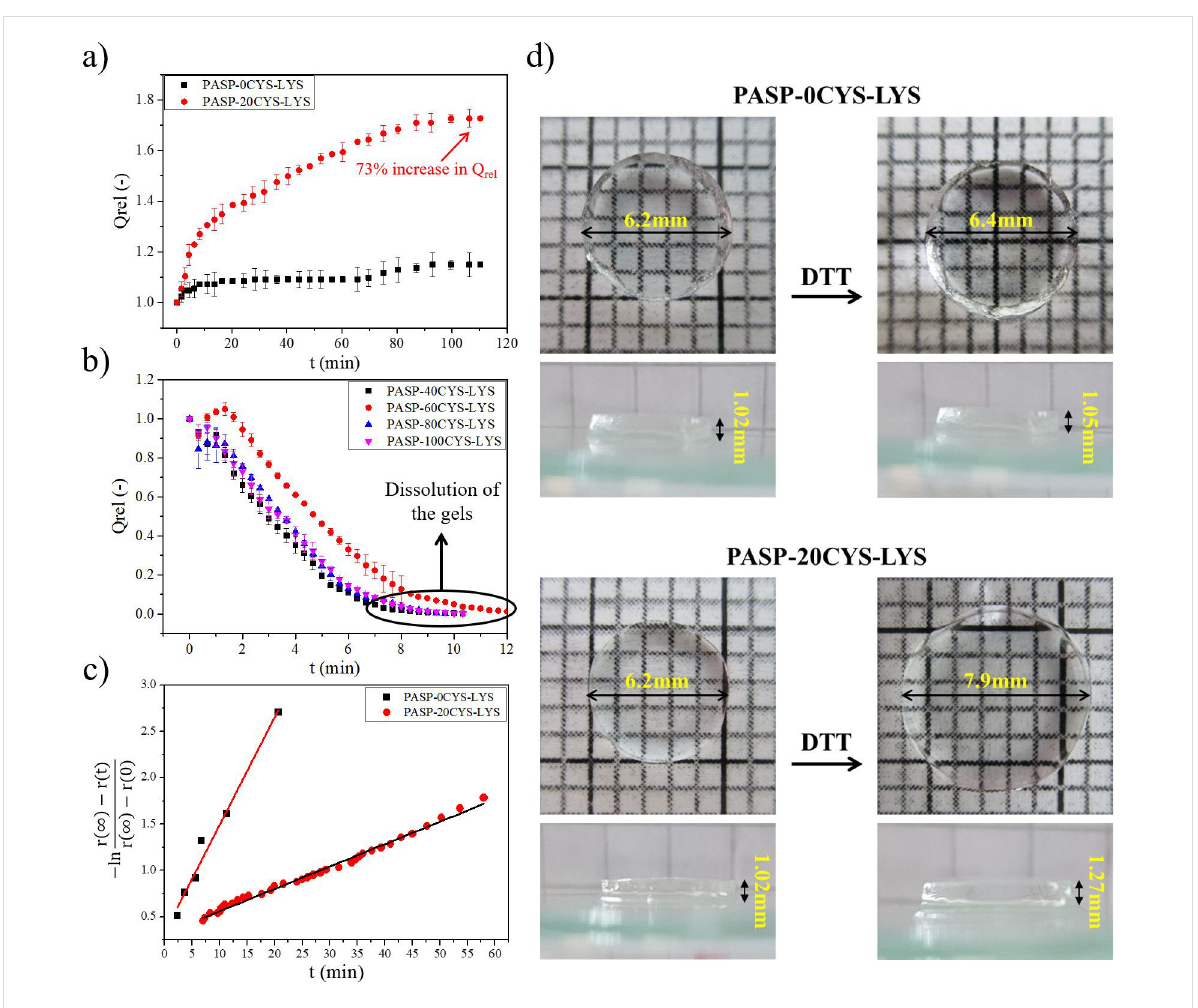
Figure 3: (a) Swelling and (b) dissolution kinetics of different PASP-XCYS-LYS gels in 0.1 M DTT solution at pH 8. (c) Description of the swelling kinetics by THB theory [12] and (d) images of the gels before and after